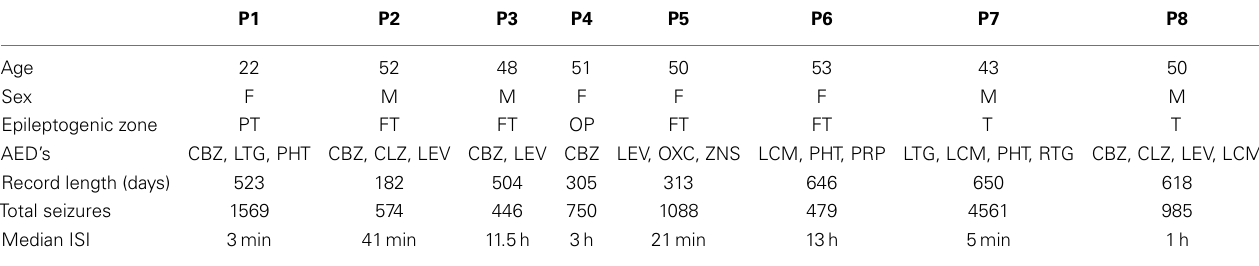
Table 1 | Summary of data